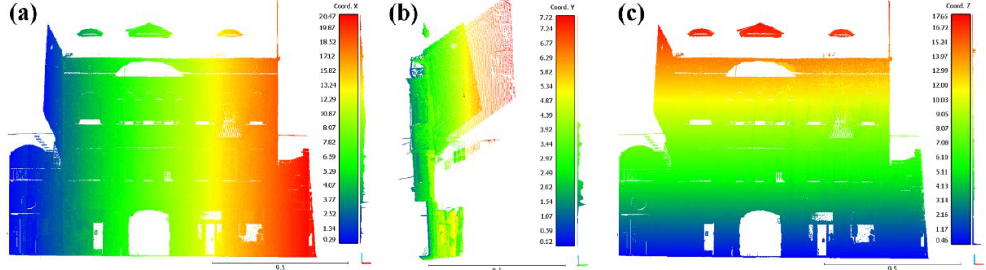
Figure 6. Presentation of the point cloud related to the Heyman House based on the X, Y and Z attributes (( a ) X coordinate, ( b ) Y coordinate, ( c ) Z coordinate).